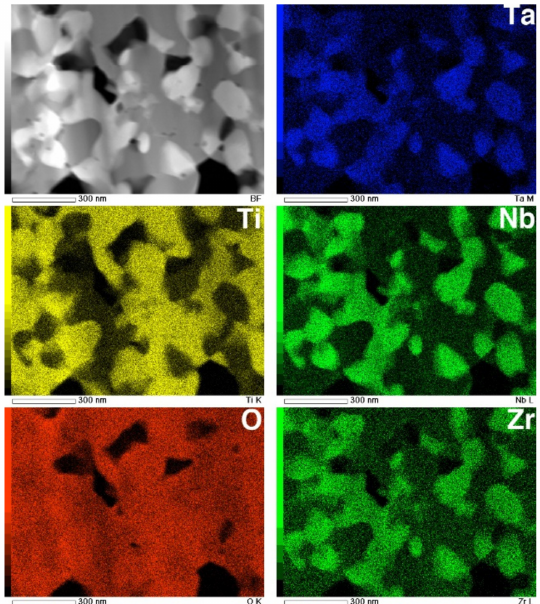
Figure 13. STEM image and EDS composition maps of Ti, O, Nb, Ta, and Zr in the cross-section of an oxide layer on Ti–29Nb–13Ta–4.6Zr. The oxidation conditions at 1273 K for 1.8 ks in